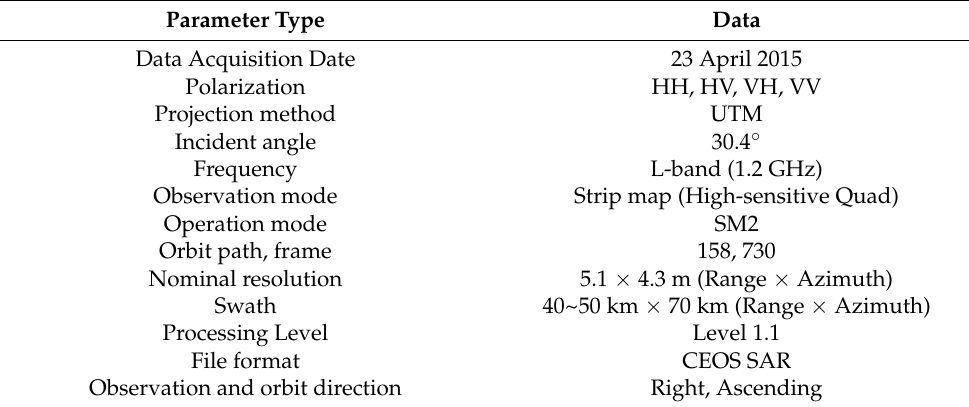
Table 1. The main parameters of the fully polarimetric PALSAR-2 data.